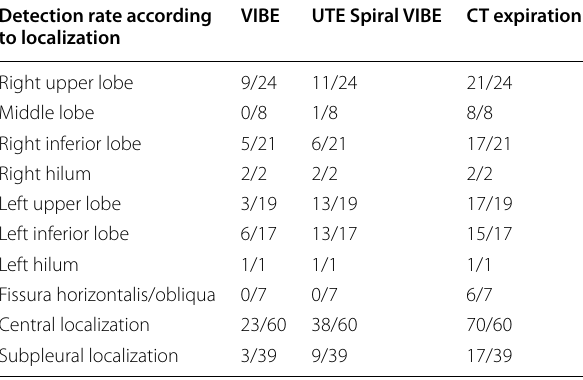
Table 3 Synopsis of the detected lung lesions according to the anatomical distribution Detection rate according to localization